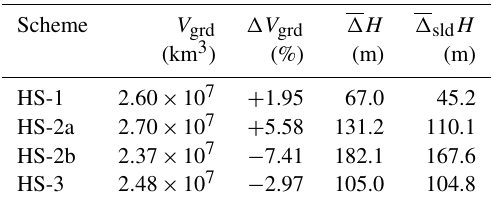
Figure 6. Difference between the modelled and observed ice thick- ness for all hybrid schemes, in metres, after additional 100kyr runs in which a median of the inferred distributions of C 0 is prescribed at the ice-sheet base. The values of C 0 derived from the SoS are not included in the median distribution. Table 4. Summary of the results for each hybrid scheme at the end of additional 100kyr runs where the median of the inferred basal sliding coefficients from all implemented hybrid schemes is prescribed as an external forcing, including the total grounded ice volume, V grd (km 3 ); a deviation from total grounded ice volume, (cid:49)V grd (%); a mean absolute error in the ice thickness, (cid:49)H (m); and a mean ice thickness error only where basal sliding operates, (cid:49) sld H